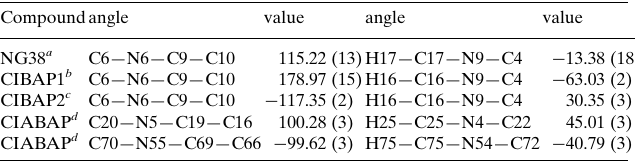
Comparative torsion angles ( (cid:1) ) for selected 2,6,9-trisubstituted purines containing the 2-chloro 6-benzylamino and 9-isopropyl unit.